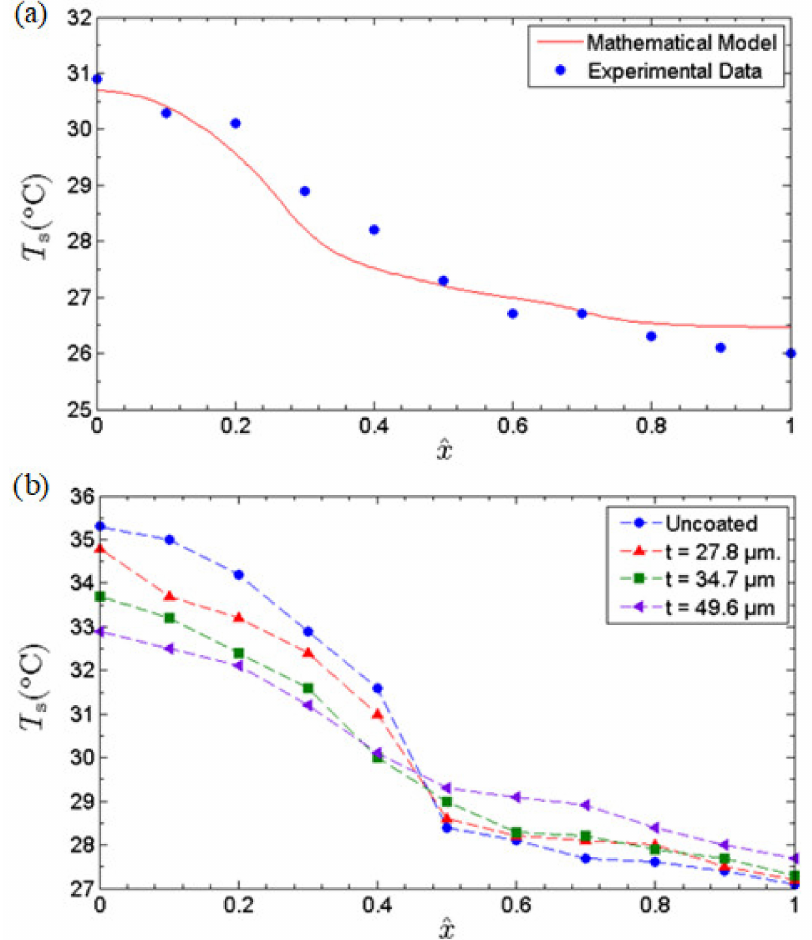
Figure 8. ( a ) Comparison of axial solid wall temperature profile of the current experimental investiga- tion with 20% charge ratio (uncoated case) against the theoretical prediction based on a mathematical model developed by Gan et al. [12] at heat input of 1.1 W. ( b ) The axial temperature profiles of the uncoated MHP and MHPs with different thicknesses of nano-wicks at a heat input of 1.6 W. To gain an insight into the effects of GNP nano-wicks, the axial temperature profiles at a heat input of 1.6 W were obtained and depicted in Figure 8a for all 3 MHPs with different thicknesses of nano-wicks along with the uncoated MHP as a benchmark.